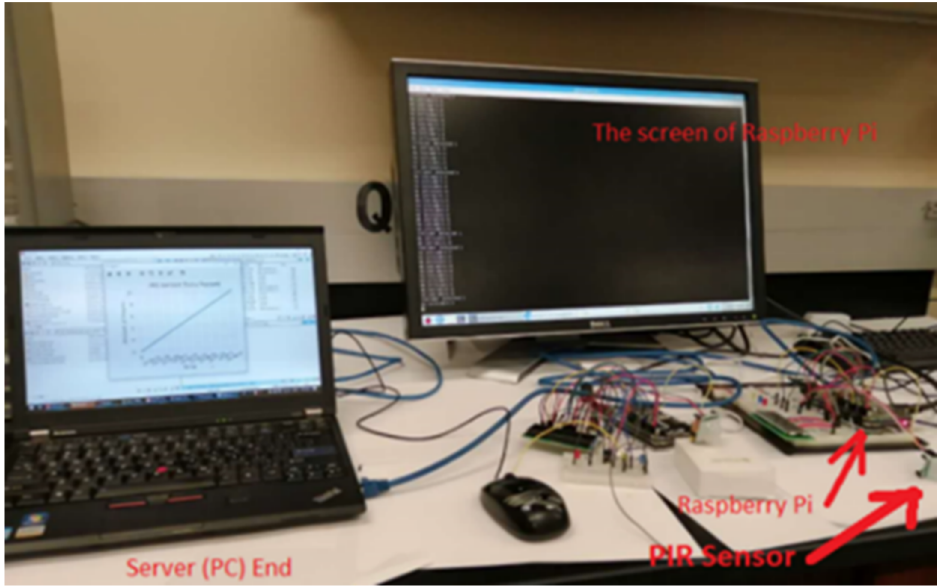
Figure 7. Testbed setting for connecting HVAC virtual machine with server to get sensor data.